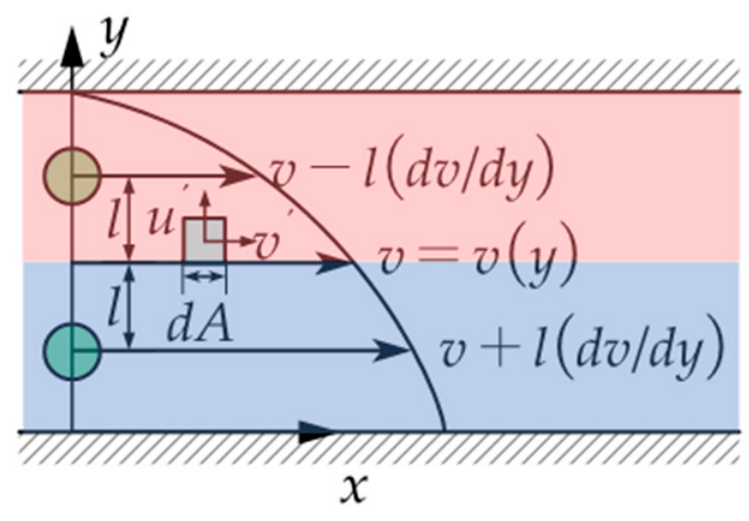
Figure 4. Velocity change diagram of fluid micro-cells under turbulent flow.